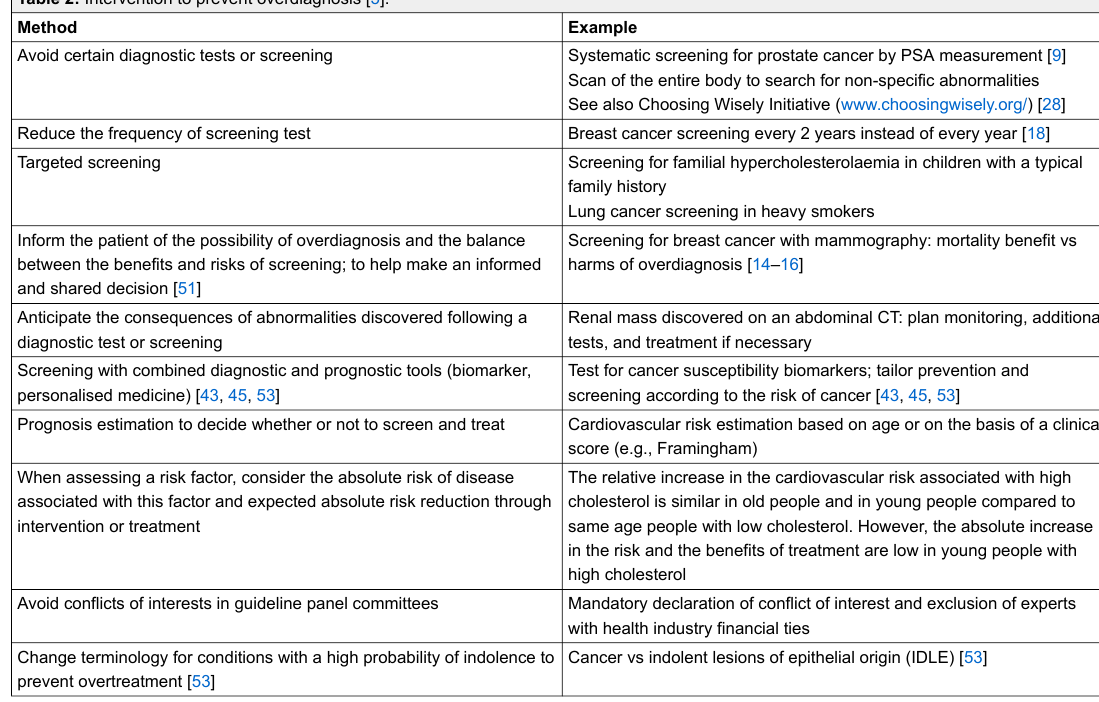
Table 2: Intervention to prevent overdiagnosis